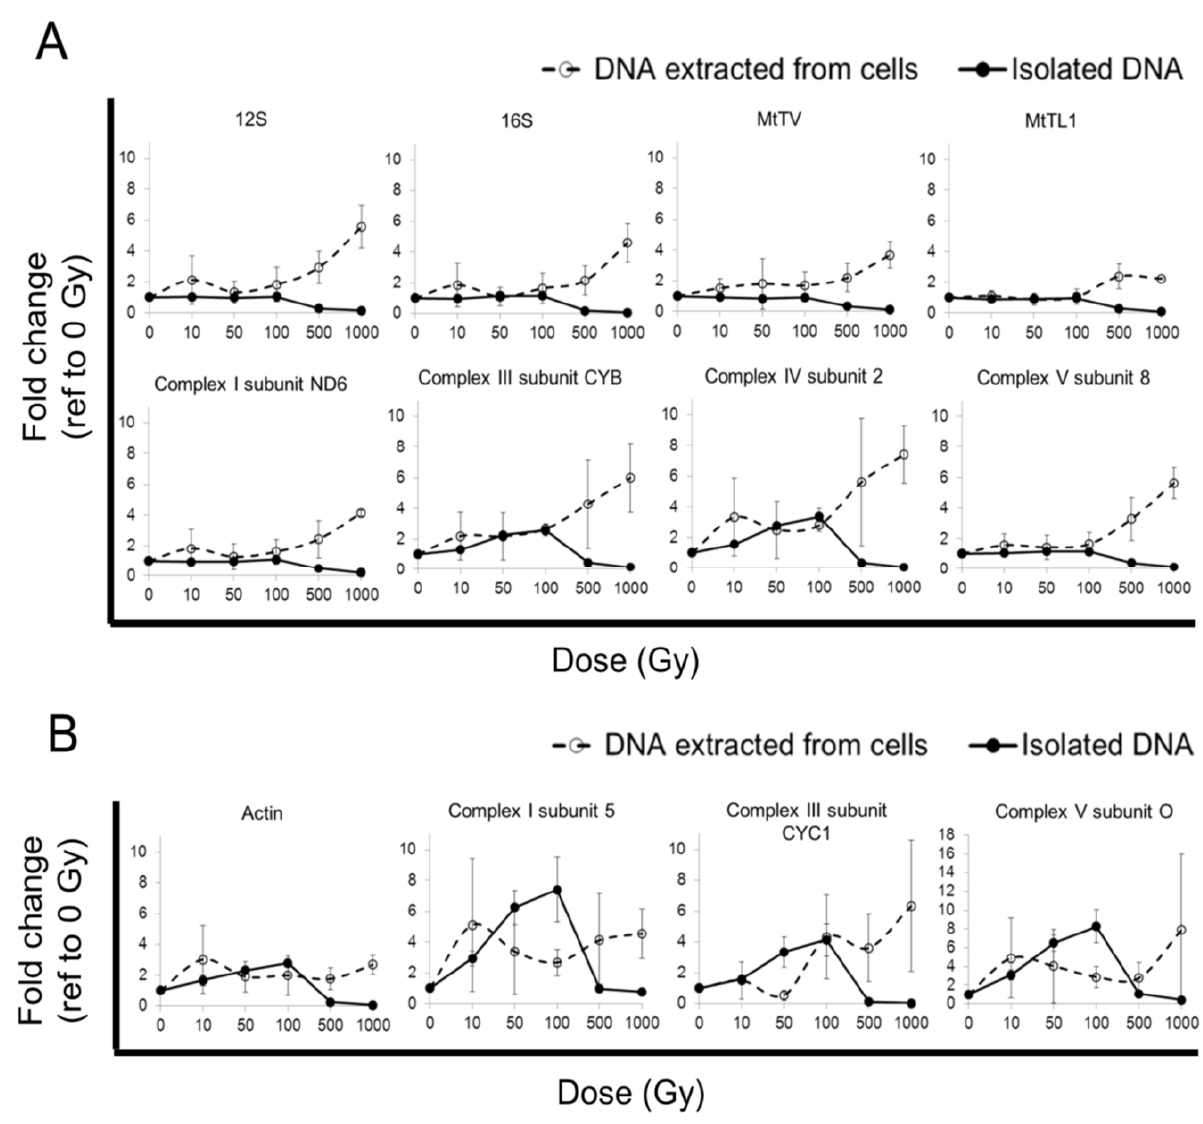
Figure 1. Gene copy number quantification in cells or isolated (cell-free) total DNA after gamma irradiation at 21 °C. JURKAT cells (dashed line) or isolated total DNA (solid line) ( N = 3) were exposed to 0 (control), 10, 50, 100, 500 and 1000 Gy of gamma radiation at room temperature (~21 °C). DNA samples were subjected to qPCR and quantified with reference to the un-irradiated sample: 2 Cq (un-irradiated sample) − Cq (irradiated sample) . The fold change in gene copy number of the tested mitochondrial ( A ) and nuclear ( B ) genes is shown. The data show the variation of fold change with radiation dose in the genes amplified from DNA extracted from irradiated cells or directly irradiated cell-free